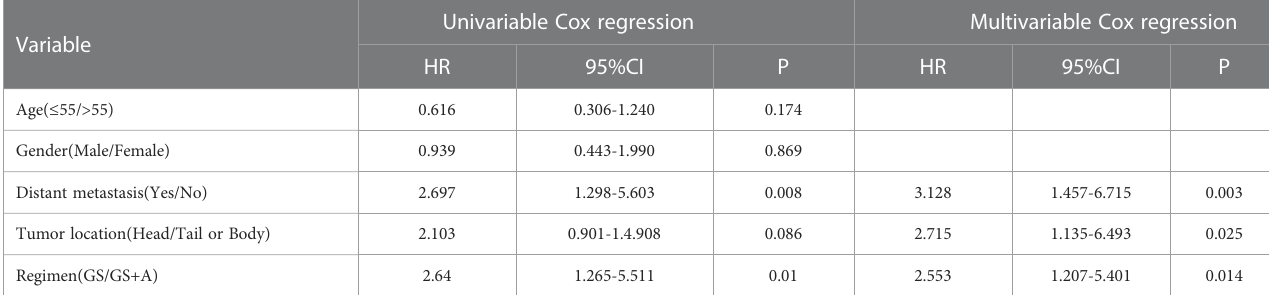
TABLE 4 Univariate and Multivariate analysis of PFS.